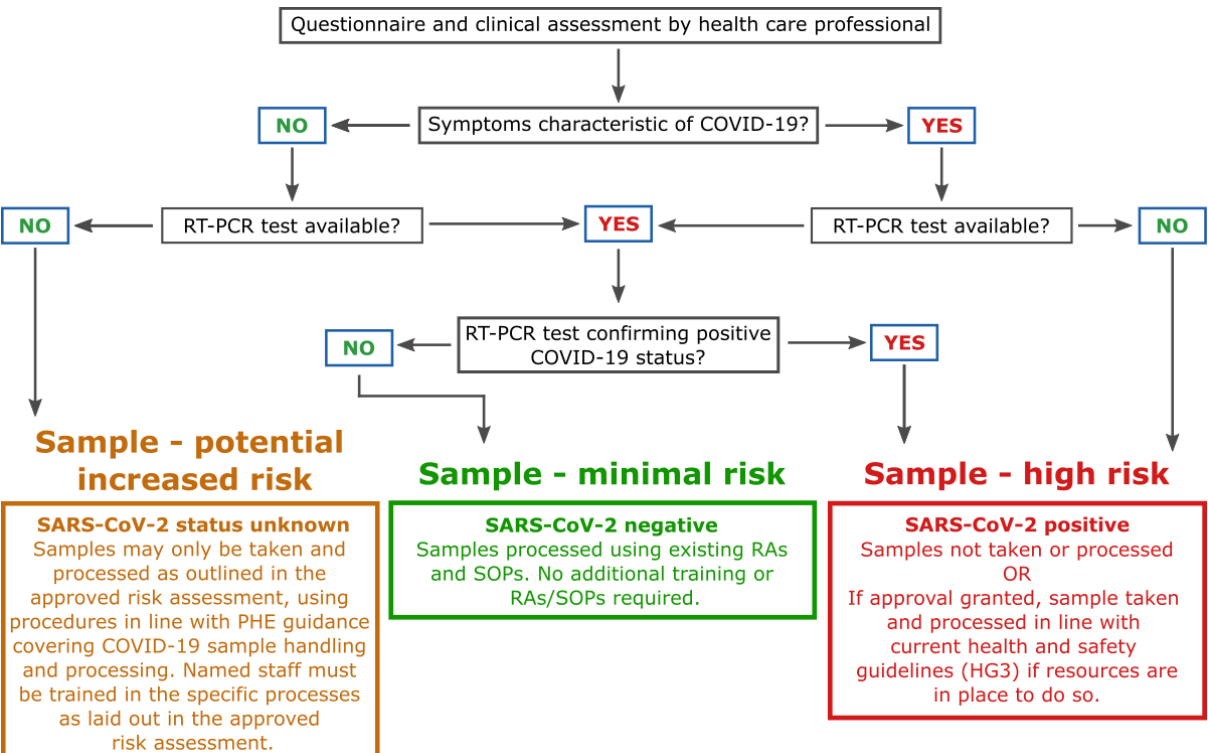
Figure 2. Clinical laboratory flow diagram for assessing sample risk. Individuals are first assessed by phone by a health care professional in the form of a questionnaire. If no clear risk is identified, patients may present at a clinic. Here, they will undergo a clinical observation to assess for characteristic symptoms of COVID-19. If resources allow, they may then undergo testing for the virus. The information will identify the risk of a particular patient sample and will inform decisions as to which samples can be taken and which can be processed safely. HG3: Hazard Group 3; PHE: Public